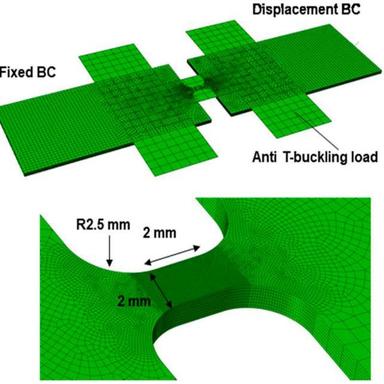
Finite element model for the in-plane compression test.